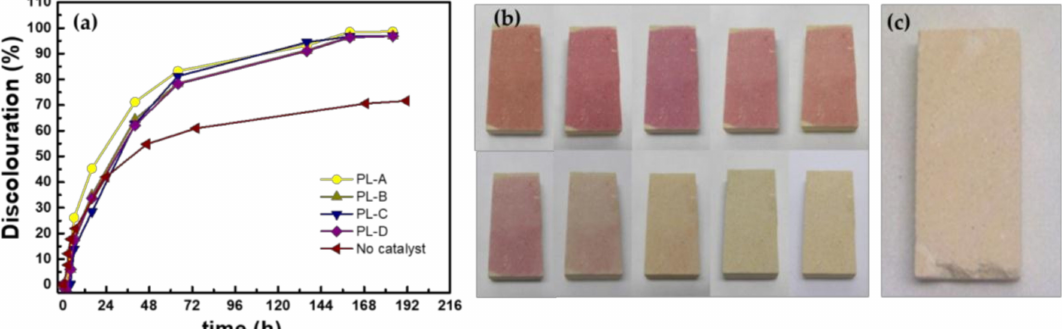
Figure 9. ( a ) The photocatalytic discolouration of Methyl Red (MR) calculated for all TiO 2 NRs coated PL samples as a function of the spraying time. The photocatalysis experiments were performed outdoor for 192 h. An untreated PL sample was considered as a reference. The reported data are presented as mean values +/ − standard deviation obtained from the analysis of two replicates. ( b ) Upper row: pictures of the PL-D sample taken at 0 h, 2 (0.1 ± 0.02%) h, 4 (6 ± 3%) h, 6 h (17 ± 1%), 16 h (34 ± 0.2%) of irradiation during the outdoor exposure for 192 h respectively. Lower row: pictures of the PL-D sample taken at 40 h, (62 ± 3%) 64 h (78 ± 4%), 136 h, 160 h (91 ± 5%), 192 h (97 ± 5%) of irradiation, respectively, during the outdoor exposition for 192 h. ( c ) Picture of an untreated PL sample.